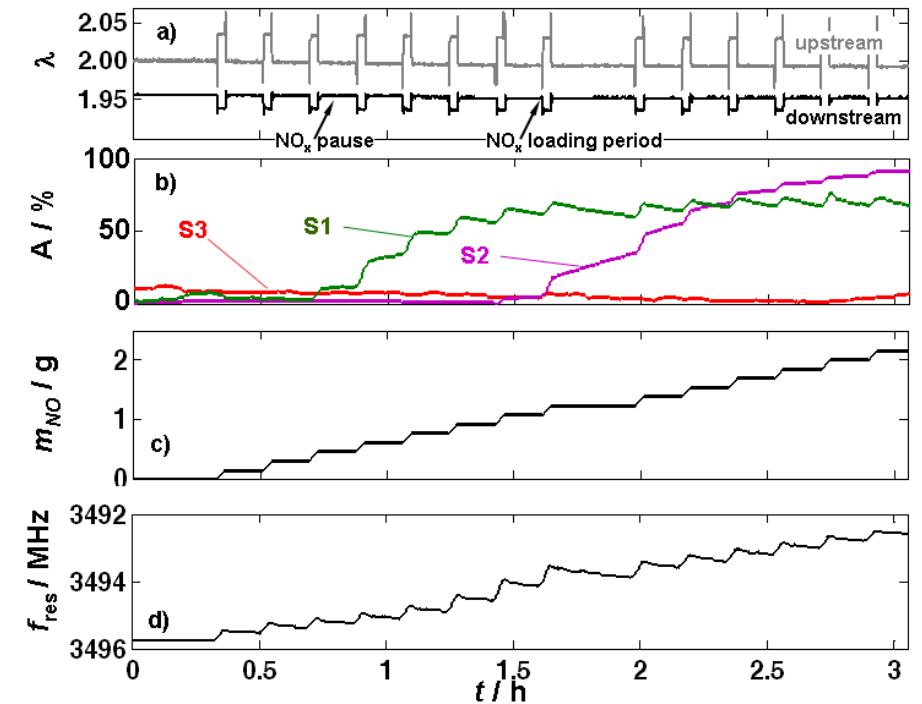
Figure 7. Time dependent results of a stepwise NO data: 320 °C; 14 pulses with 2,750 ppm NO pauses of 540 s. (a) λ upstream and downstream of the catalyst, measured by the NO x UEGO sensor. (b) Signals of the impedimetric catalyst sensors (S1, S2, and S3) mounted equidistantly in the catalyst volume. (c) Calculated NO (d) Microwave cavity resonance